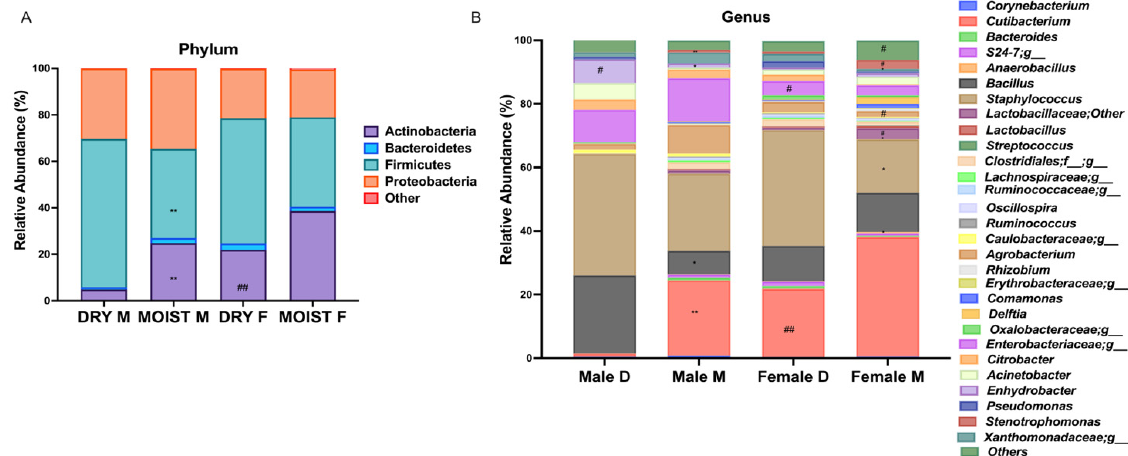
Figure 4. Comparison of the microbiota associated with moist and dry forehead skins with regard to gender differences. ( A ) Phylum level. ( B ) Genus level. Data were analyzed with unpaired parametric t -test compared between skin types within each sex * p < 0.05, ** p < 0.01 and compared between sex for each skin type # p < 0.05, ## p < 0.01. M = moist, D = dry.